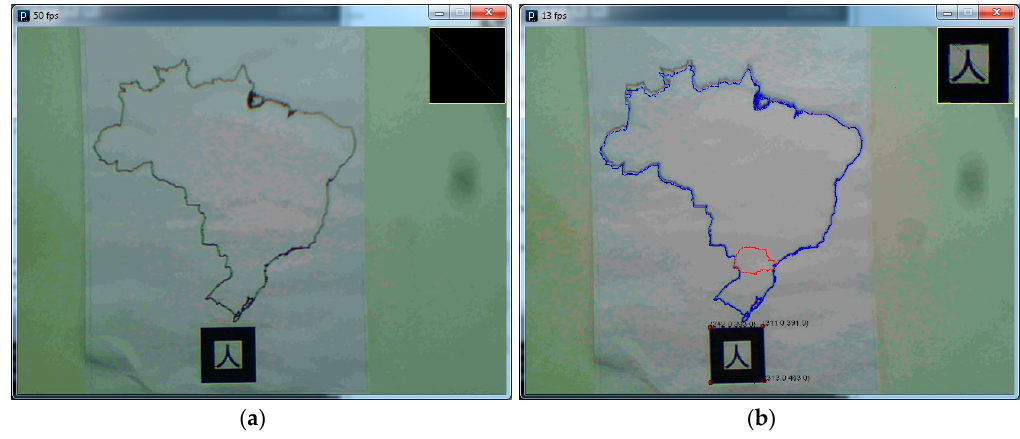
Figure 2. Layers of Information Shown in Step 1 by the AR System. ( a ) original printed map of Brazil’s boundaries, and ( b ) map augmented with the addition of digital information and the outline of Brazil and the State of Paraná. (Developed by the authors).